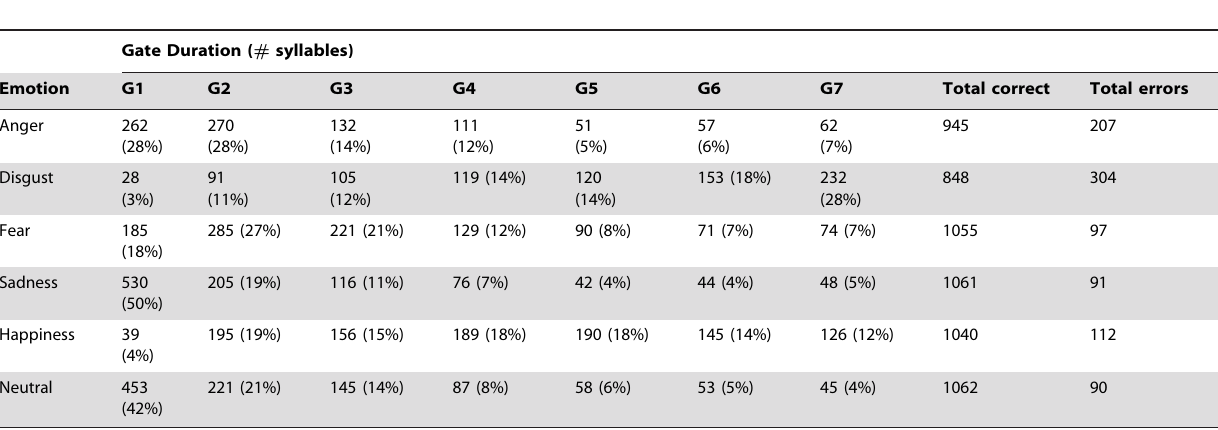
Table 4. Frequency of emotion identification points observed at each gate duration interval of the utterance and the frequency of errors observed for each emotion (n=1152 total